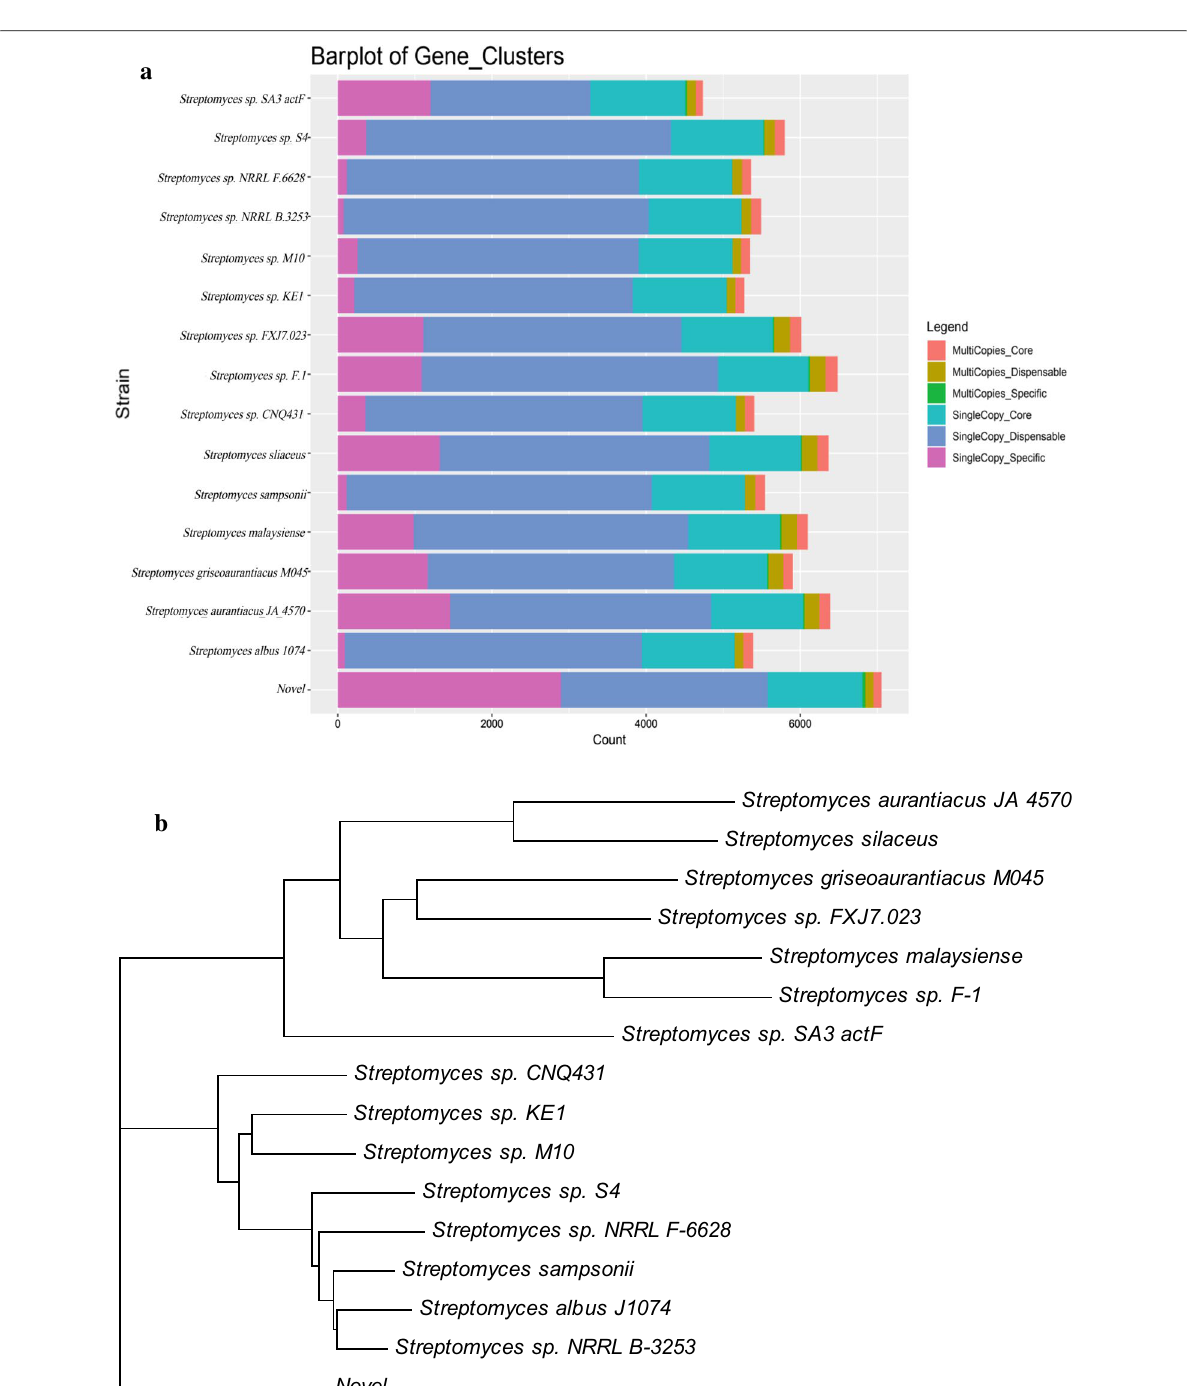
unigenes were classified into the cellular component cat- egory, and 6656 unigenes were classified into the molec- ular function category (Fig. 3b). The largest functional